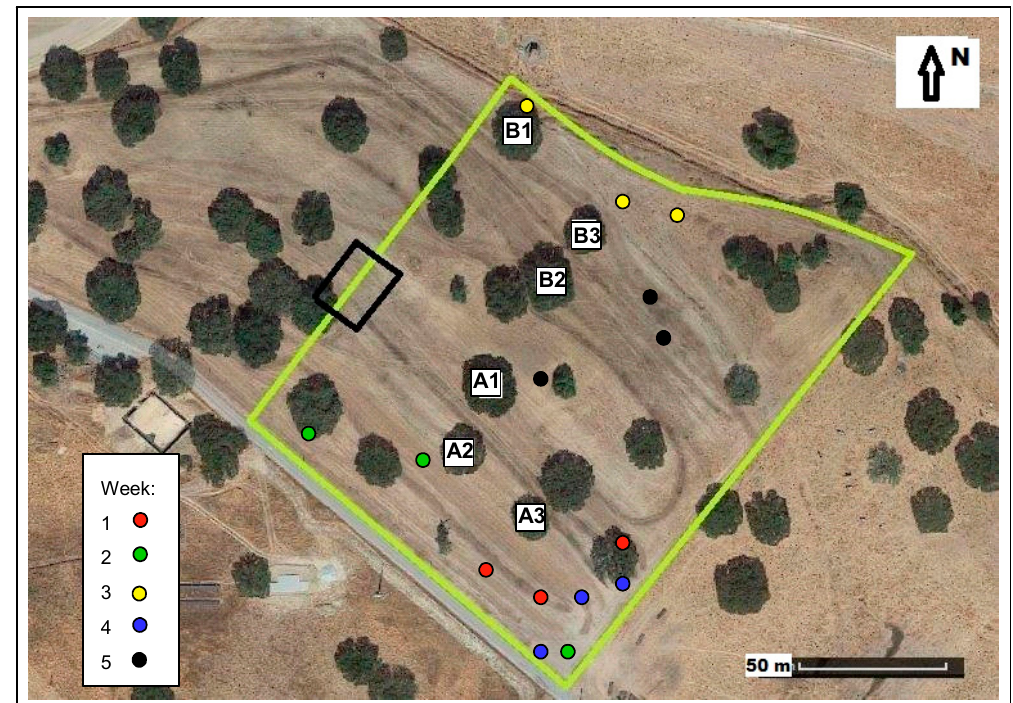
Figure 22. Location of the three most grazed patches in the studied field within a 24 h period in weeks 1 to 5 of April 2016 (green line: outer boundary of the studied field; A1–A3 and B1–B3: tree codes).